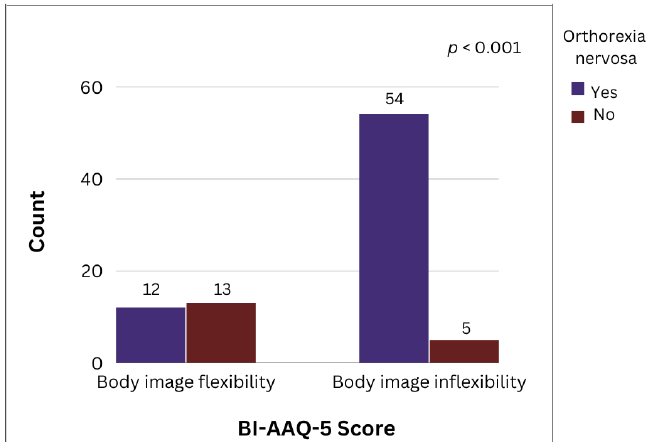
Figure 2. Correlation between orthorexia nervosa (ON) evaluated with the ORTHO-15 questionnaire and body image inflexibility according to the BI-AAQ-5 score in professional dancers of normal weight ( n = 84) ( p < 0.001).